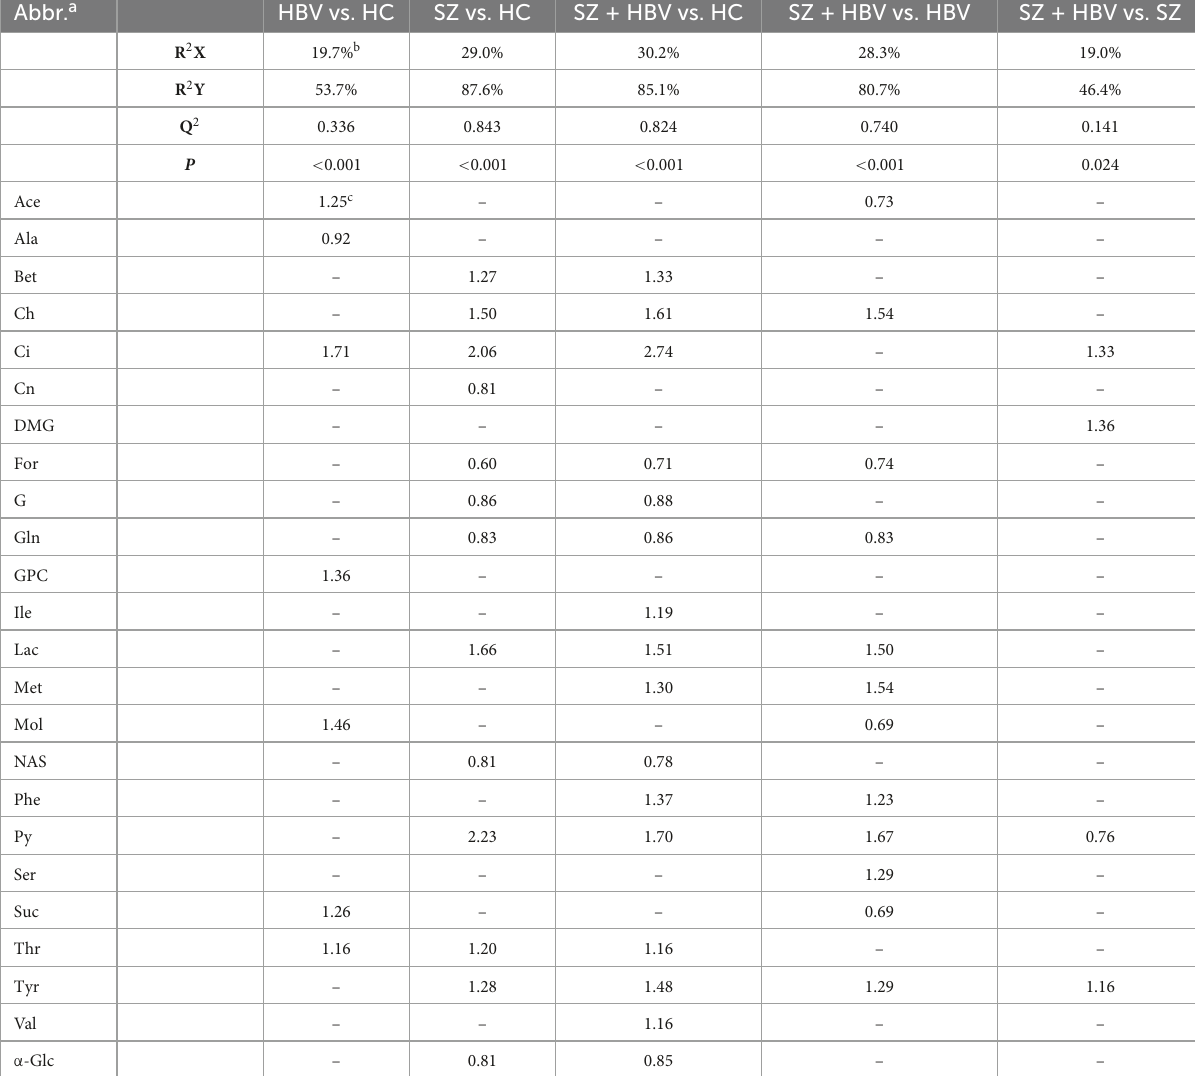
TABLE 3 Summary of the identified differential metabolites constructed from the comparison